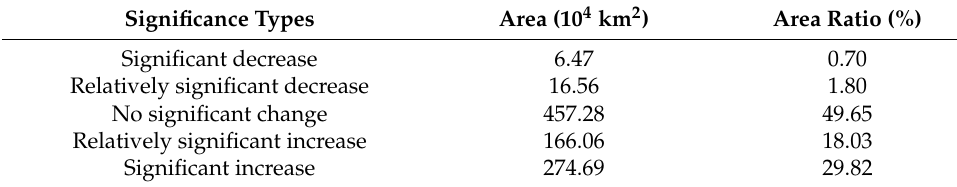
Table 6. Statistical table for the significance test of the NPP